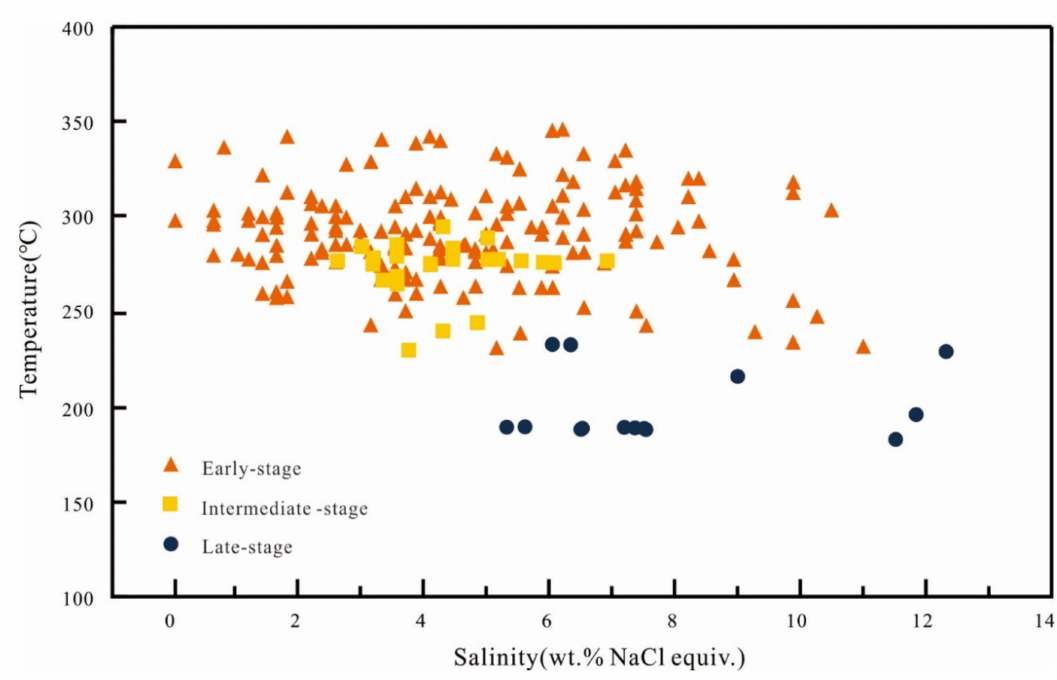
Figure 13. Plot of homogenization temperature (T h ) vs. salinity of FIs in quartz from the Juyuan